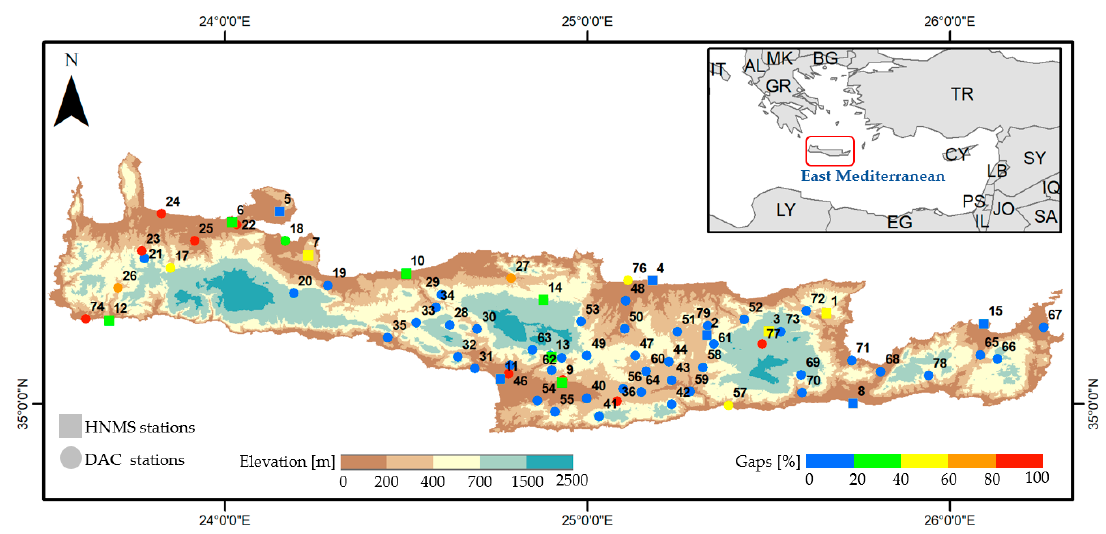
Figure 1. Case study region and the two precipitation networks considered, indicated by different shapes, i.e., circles for the Decentralized Administration of Crete and squares for the Hellenic National Meteorological Service. Colors blue to red indicate the percentage of the gaps in daily scale between 1 September 1973 and 31 August 2015 and brown to light blue indicate the elevation in meters a.s.l. The stations’ enumeration corresponds to Table A1.